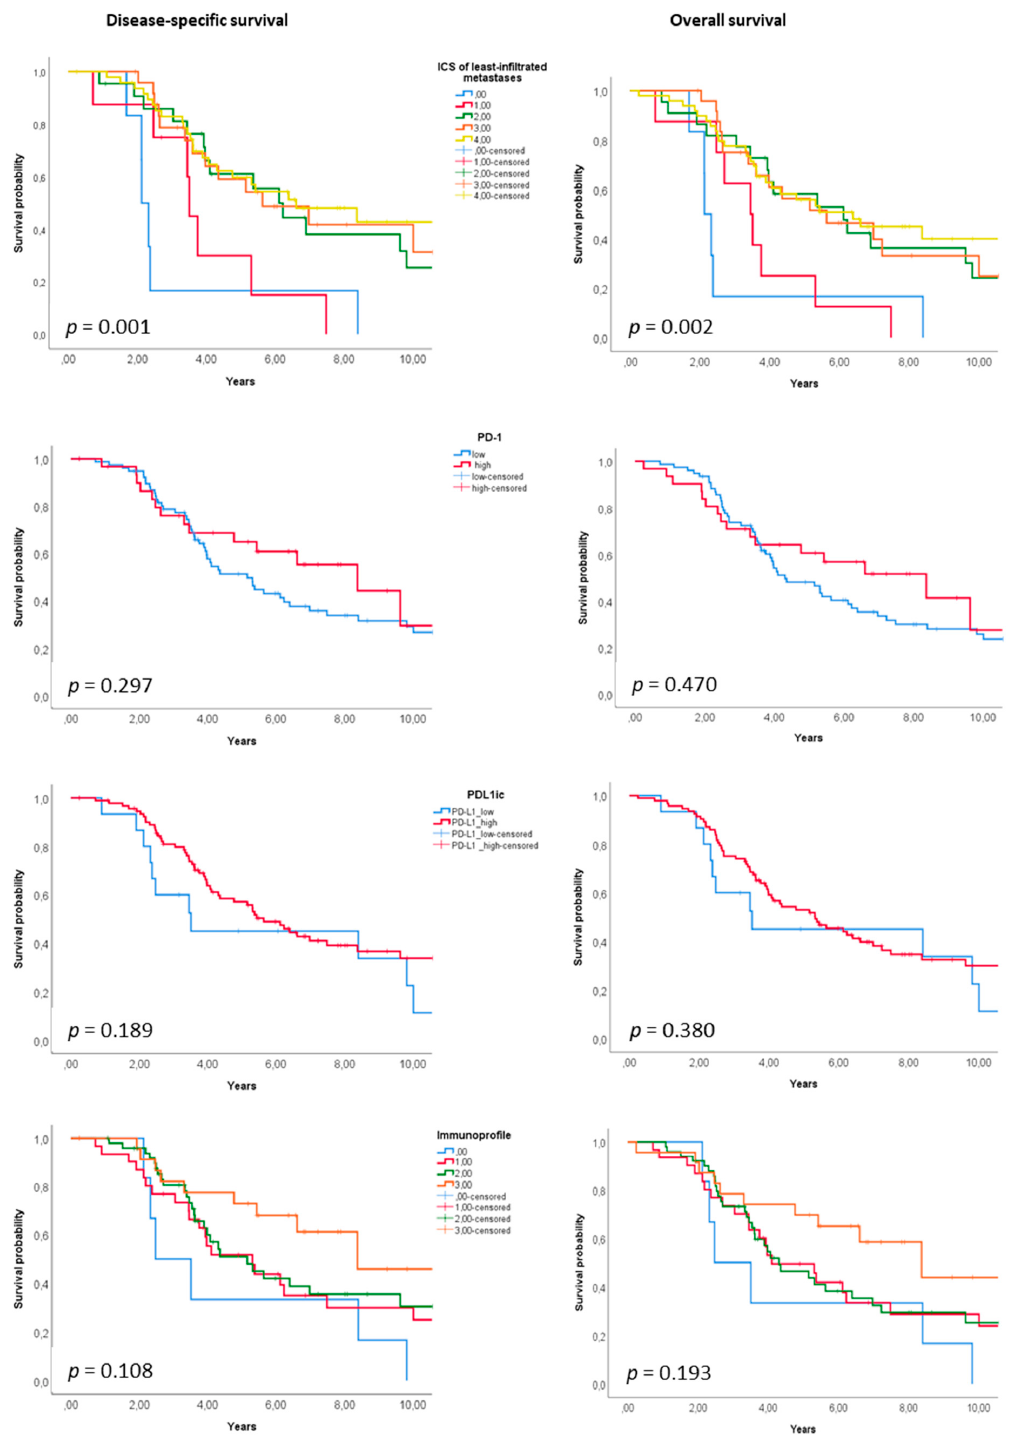
Figure 6. Disease-specific and overall survival according to ICS 0–4, PD-1, PD-L1IC and immunoprofile of least-infiltrated metastases.